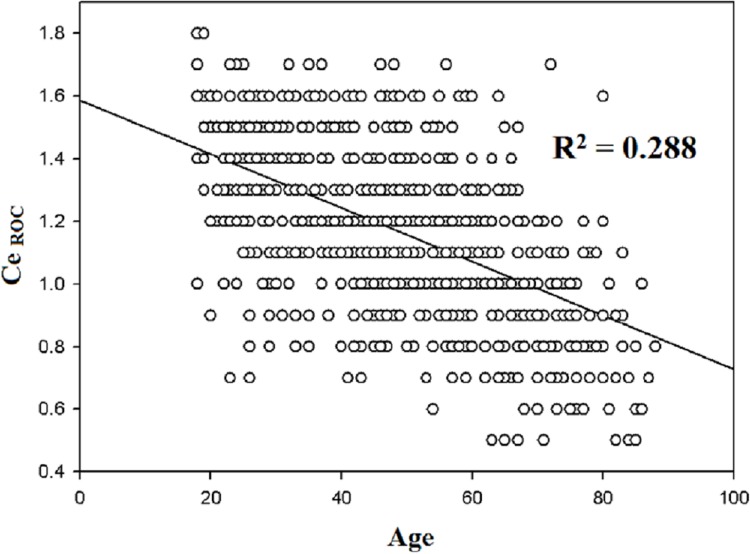
Linear regression between the CeROC and age in 794 patients.Statistically significant correlation (R2 = 0.288; p < 0.01) and negative slope.